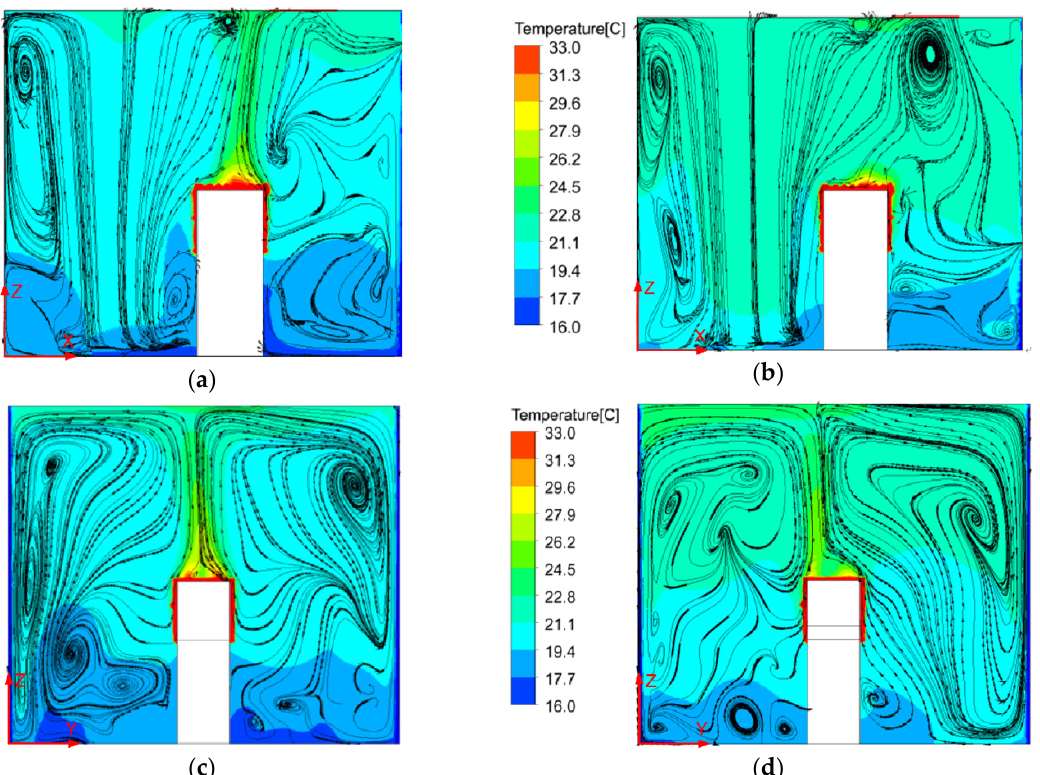
Figure 4. Temperature and streamline distributions for ( a ) H = 2.3 m setting at the Plane Y = 0; ( b ) H = 0.8 m setting at the Plane Y = 0; ( c ) H = 2.3 m setting at the Plane X = 1.8; and, ( d ) H = 0.8 m setting at the Plane X = 1.8.